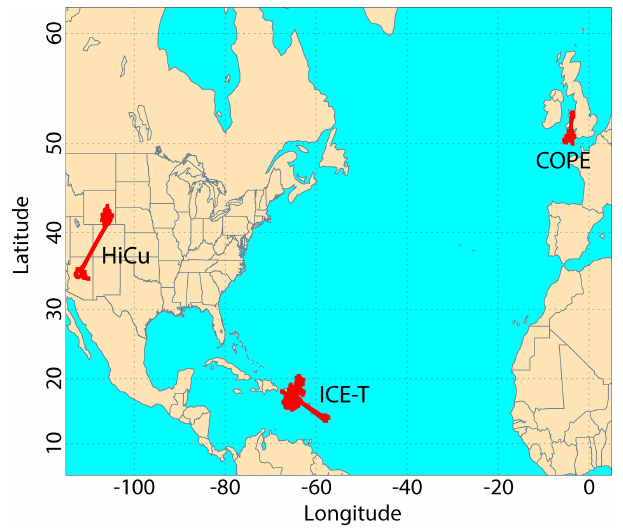
Figure 1. Flight tracks for the three field campaigns: HiCu, COPE, and